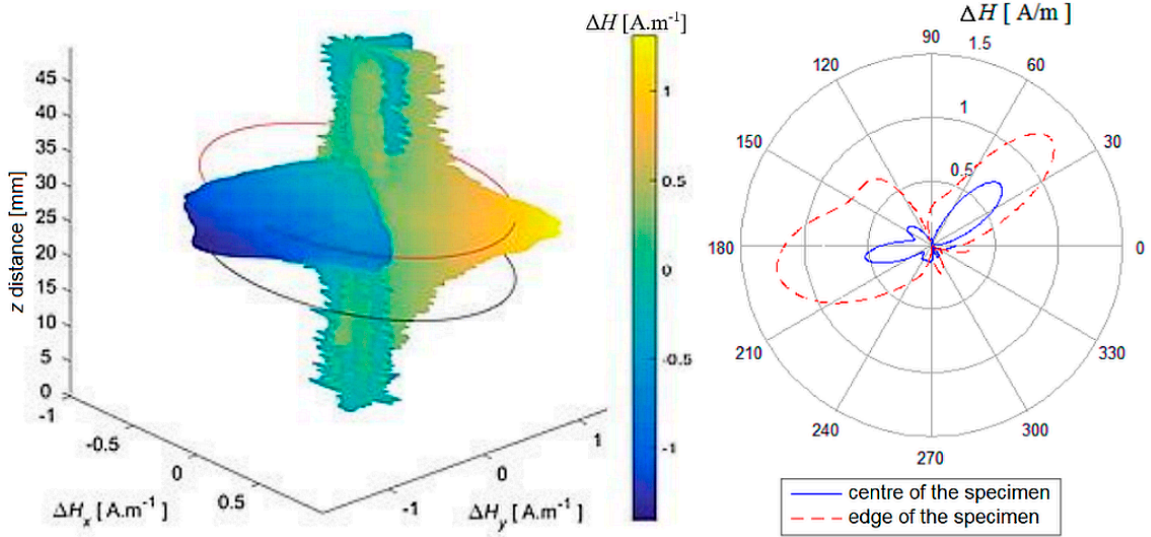
Figure 14. Distribution and reconstruction of the magnetic field of the AISI 316L shell, PD = 40%.